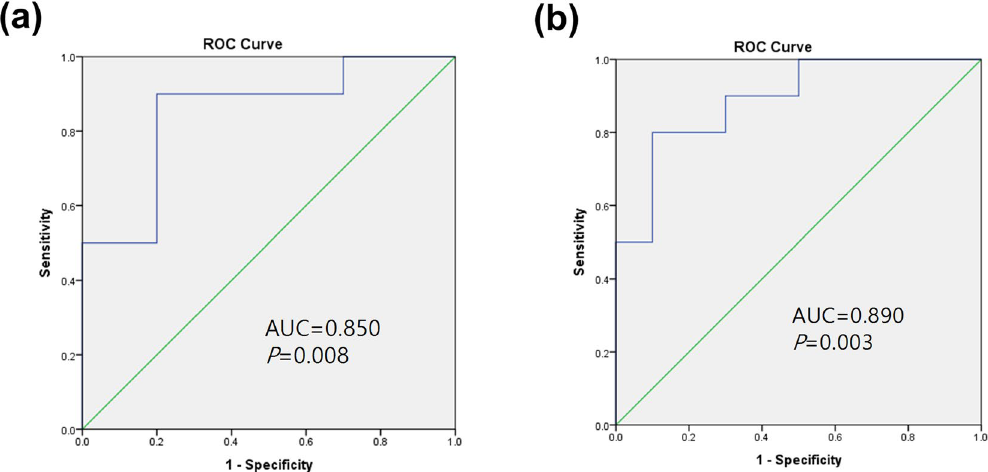
Figure 3. Diagnostic values of cis- to trans- UCA ratio in distinguishing CSU from AD patients, using receiver operating characteristic curve. Diagnostic values of cis-to trans-UCA ratio in ( a ) lesional skins and ( b ) non- lesional skins are shown. AUC, area under the curve.